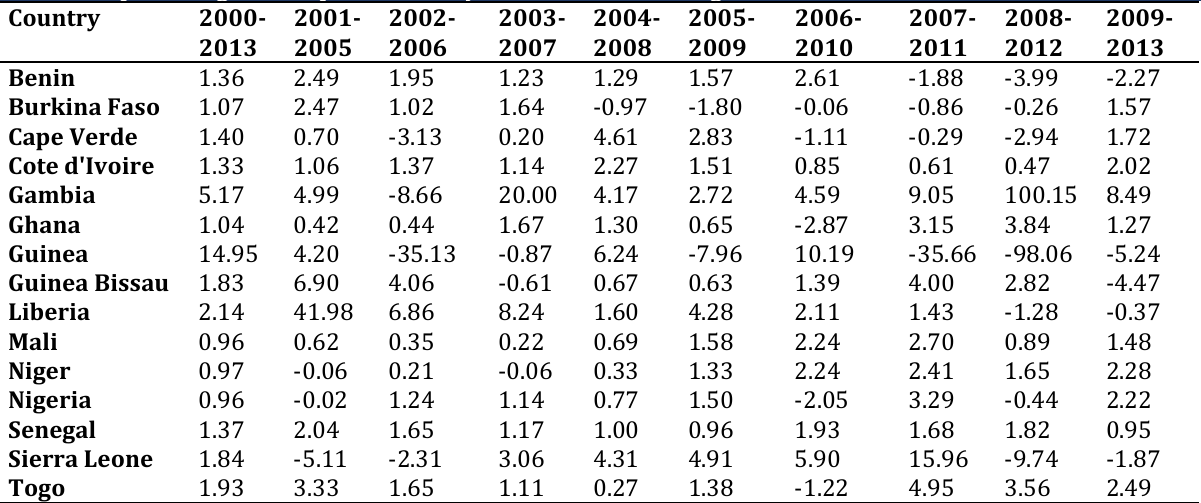
Table 6: Export freight transport elasticity for ECOWAS Sub-Region Country 2000-